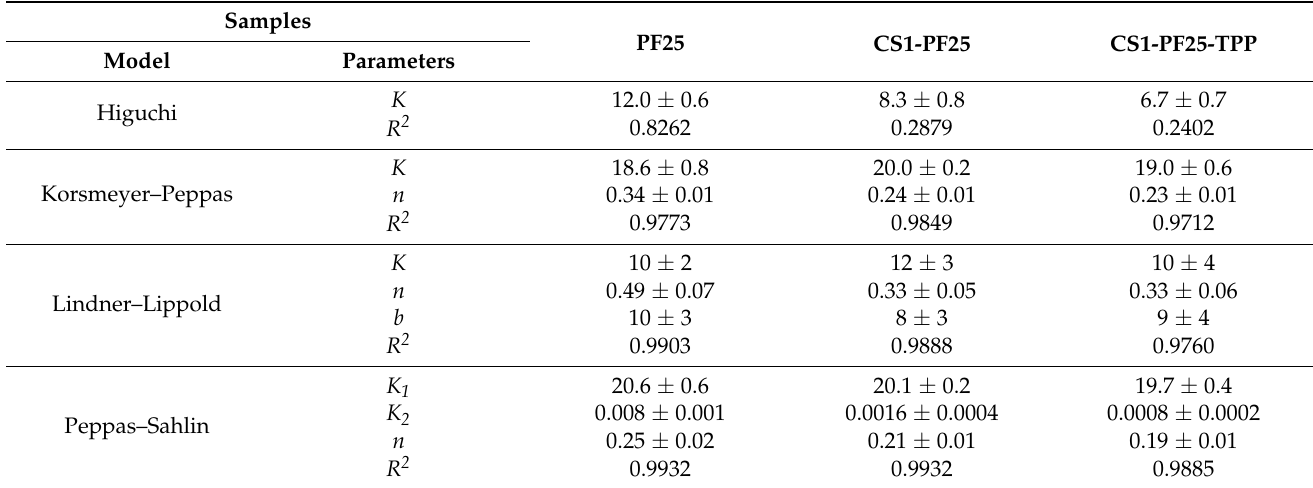
Table 2. Summary of the adjustment parameters to the release models for the different